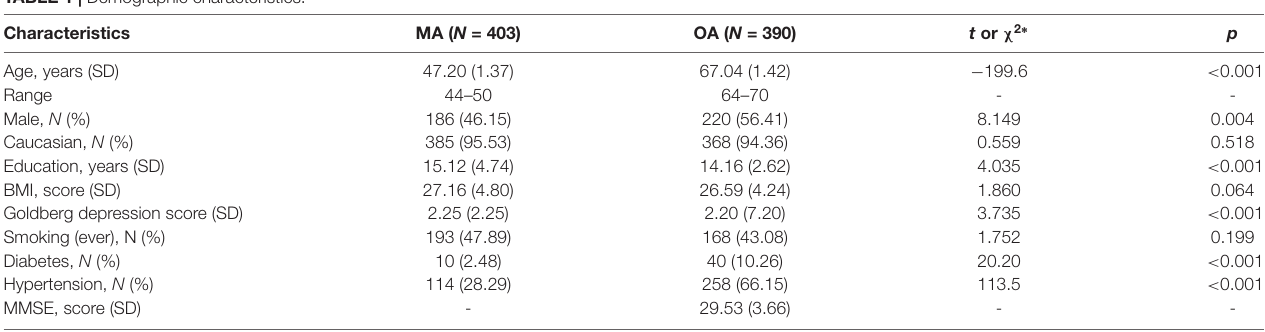
TABLE 1 | Demographic